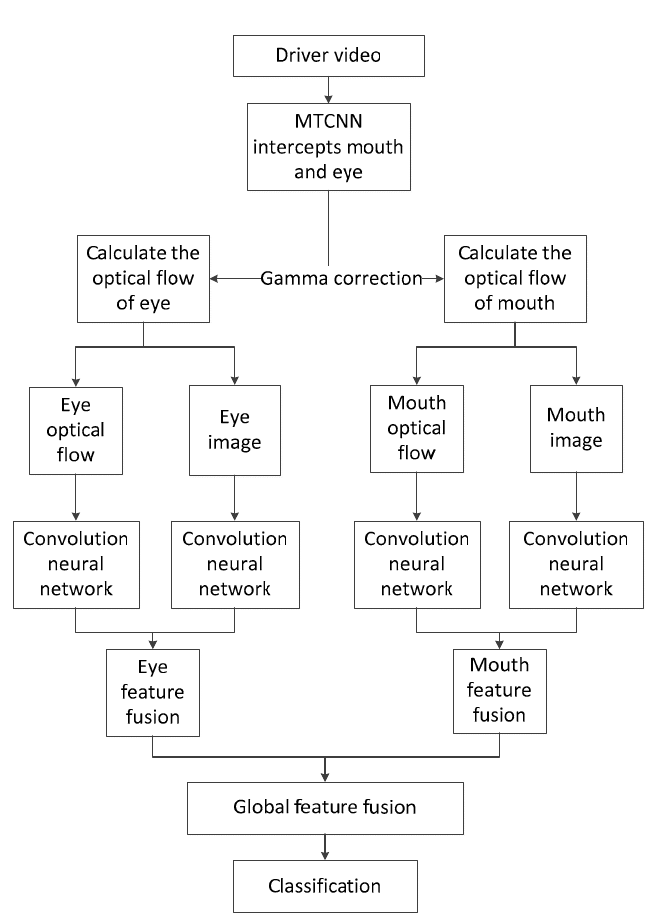
Figure 1. Algorithm flowchart for driver fatigue detection.